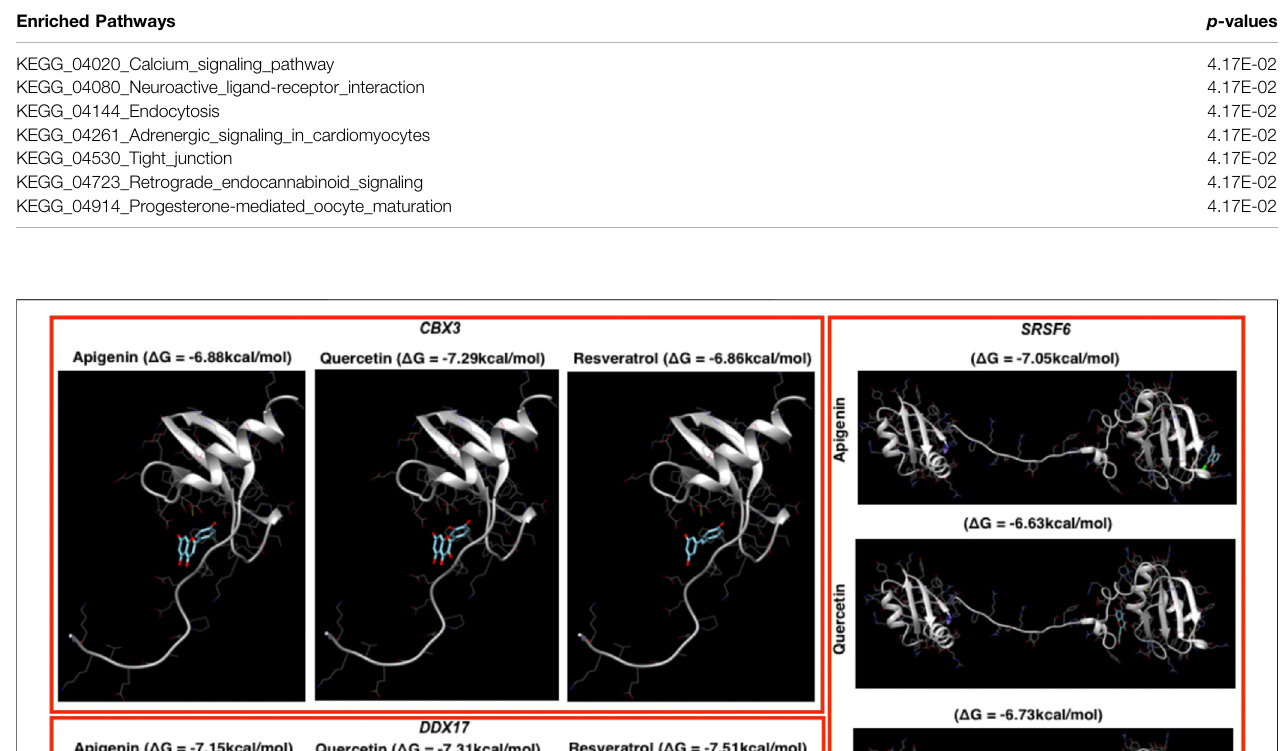
Frontiers in Genetics |